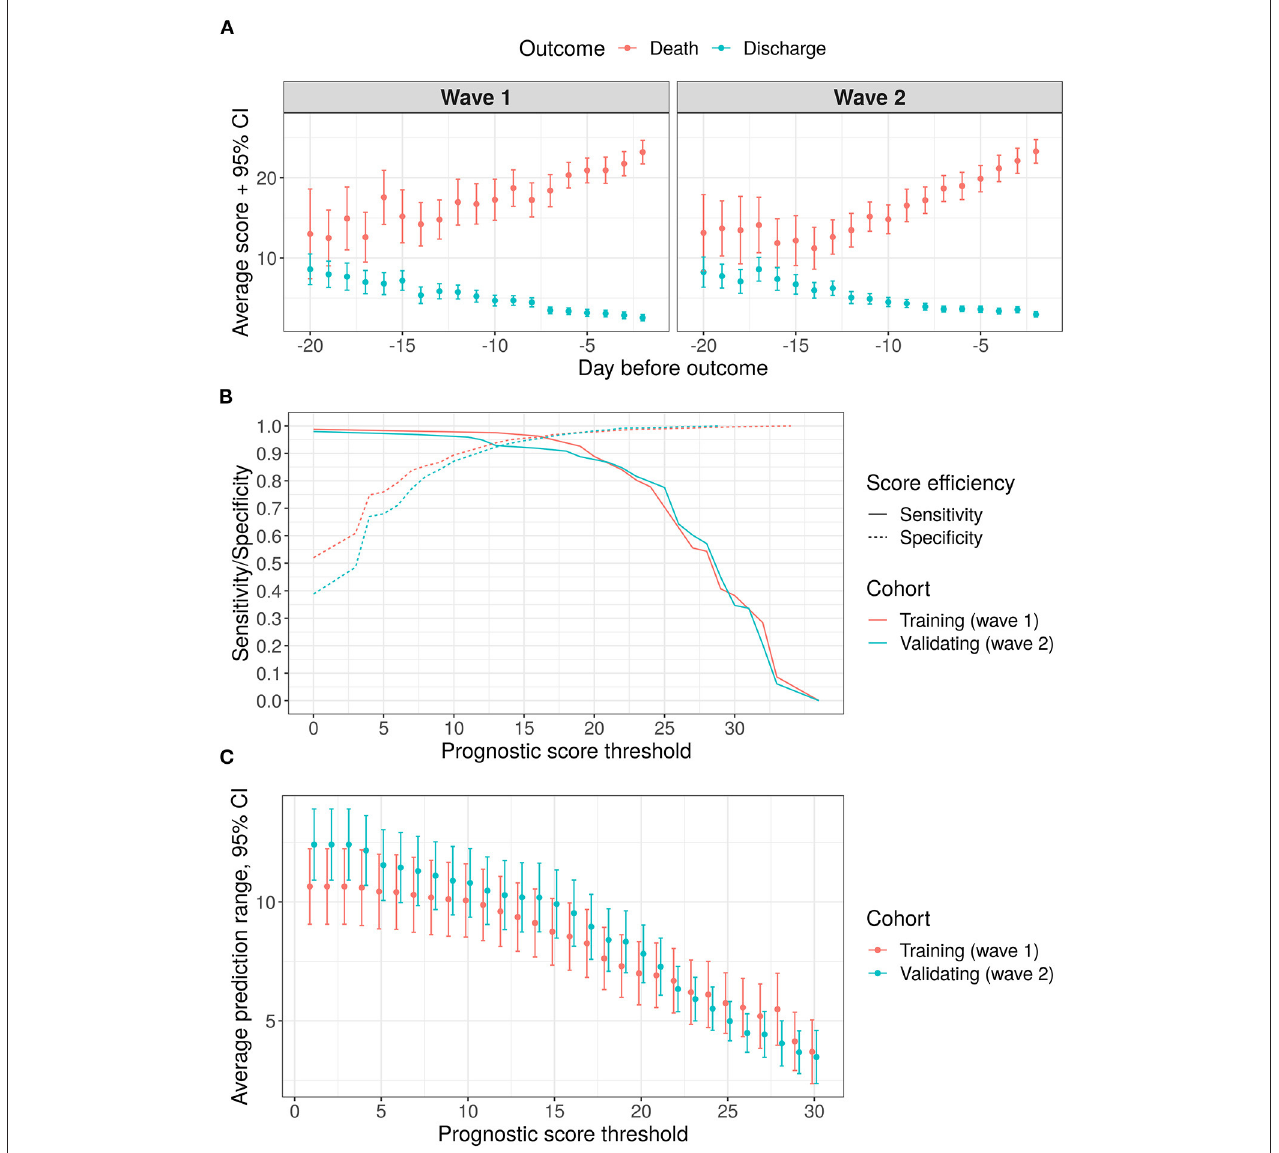
FIGURE 4 | Results of score validation, points represent mean values, error bars − 95% confidence intervals for the mean values (A) average score variation within 3 weeks before outcome: (B) sensitivity/specificity trade-off for various threshold levels; (C) prediction range dependency on a chosen threshold